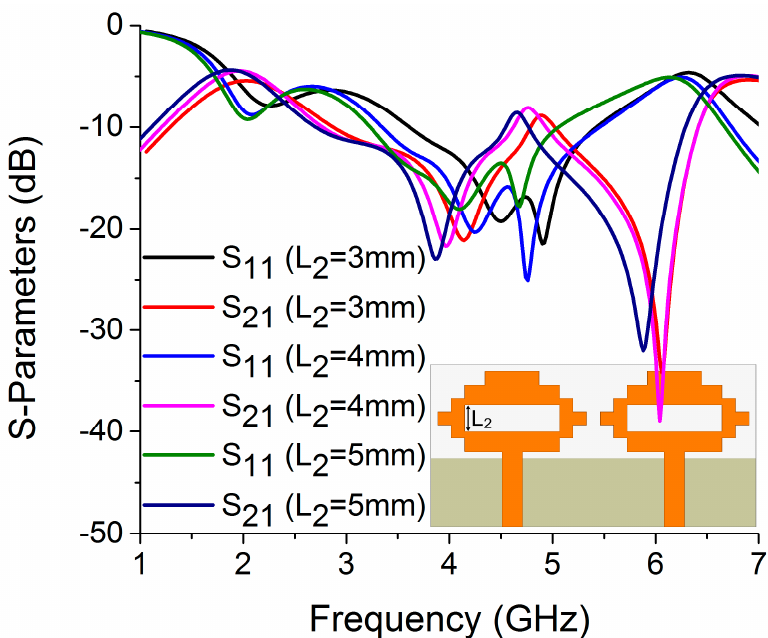
Figure 19. Influence of L 2 on S-parameters.